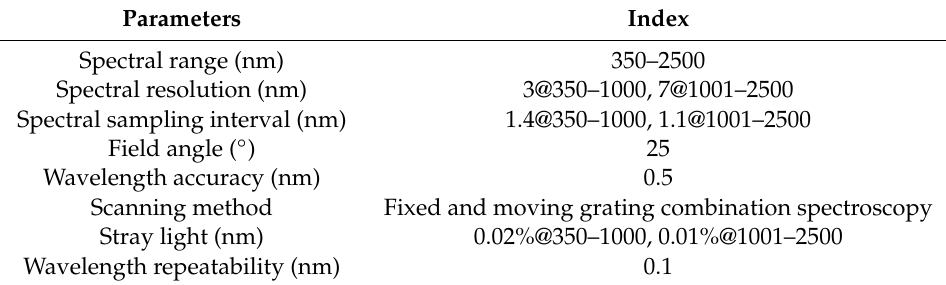
Table 1. Parameters of the ASD-FieldSpec4